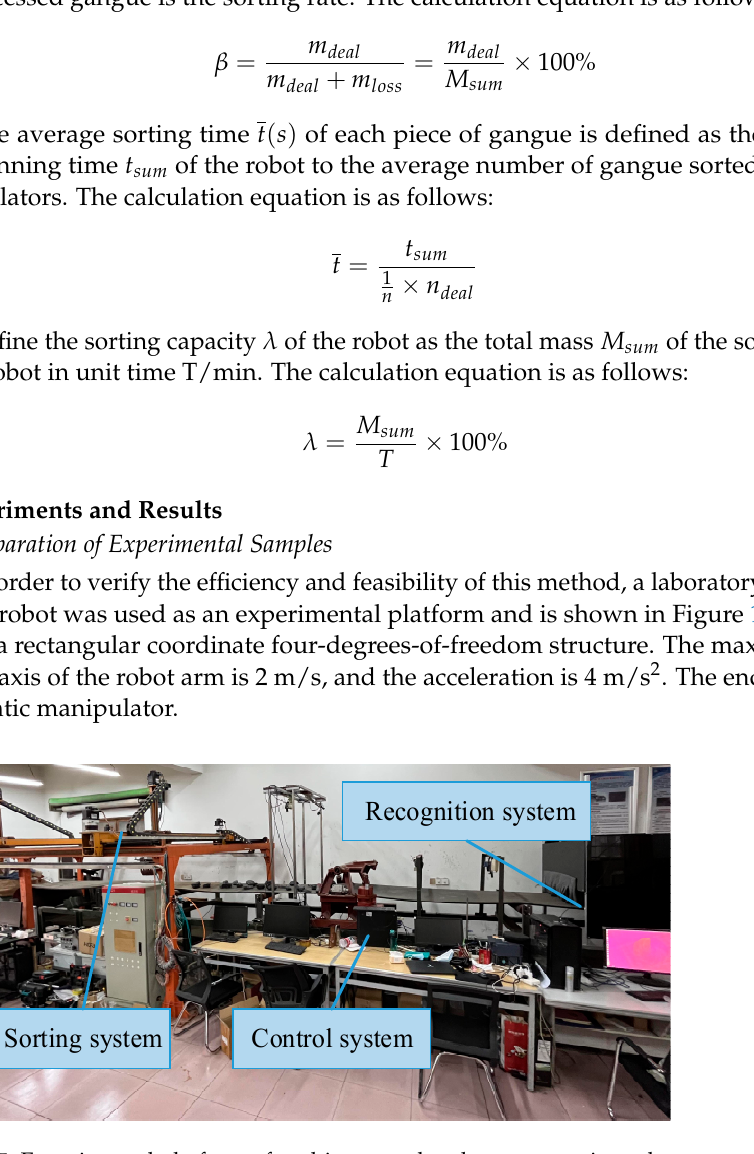
Figure 15. Experimental platform of multi-arm coal and gangue sorting robot.